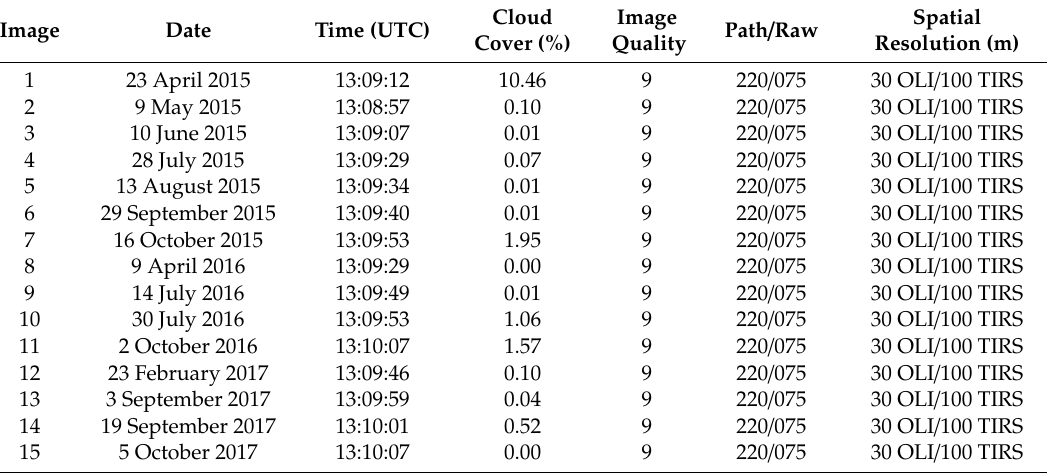
Table 1. Methodological procedure for modeling surface urban heat islands.